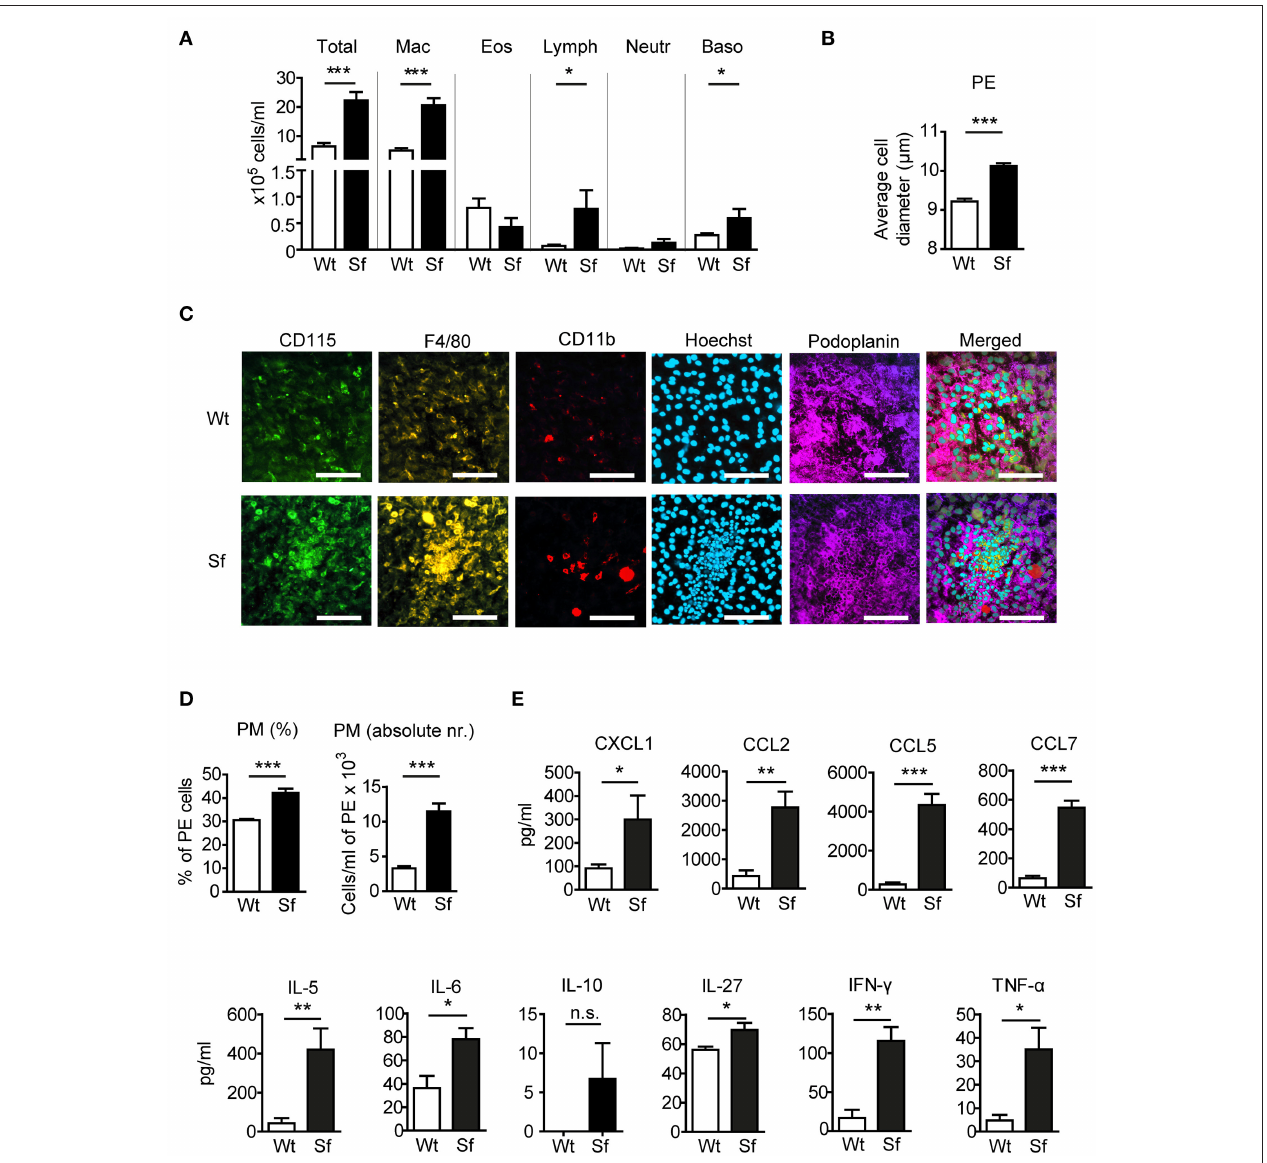
FIGURE 1 | Mice that lack regulatory T cells have elevated peritoneal and macrophage counts and cytokine/chemokine levels . (A) Total and differential counts of peritoneal exudate (PE) cells isolated from scurfy (Sf) mice or littermate controls (Wt), fixed with cytospin centrifuge, and stained with May-Grünwald/Giemsa ( n > 15 per group). (B) Average cell diameter in PE determined by automated cell analyser ( n = 9–10). (C) Chipcytometry stainings of omentum majus fixed on ZellSafe TM chips; scale bar = 100 µ m. (D) Percentages ( n = 8–9) total cell numbers ( n = 5–6) of CD115 + CD11b + F4/80 + peritoneal macrophages (PM) determined by flow cytometry and automated cell analyser. (E) Chemokine and cytokine levels in peritoneal fluid, measured by bead-based multiplex immunoassay ( n = 5 samples, each pooled from 2–3 mice). Statistical analyses were performed using unpaired Student’s t -test, * p < 0.05, ** p < 0.01, *** p < 0.001. n.s., not significant; Mac, macrophages; Eos, eosinophils; Lymph, lymphocytes; Neutr, neutrophils; Baso,